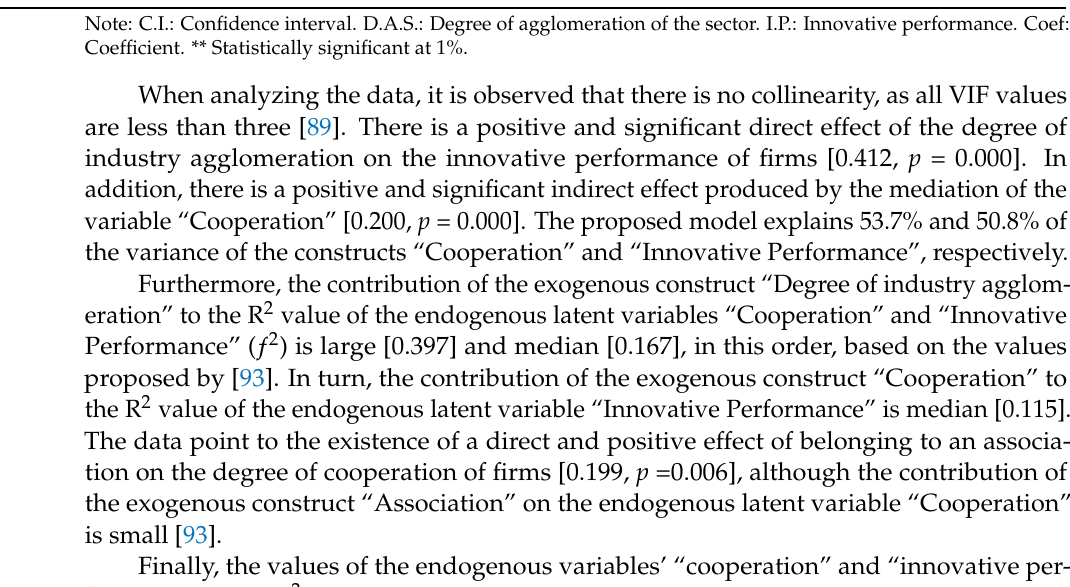
Table 7. Summary of indirect effects.